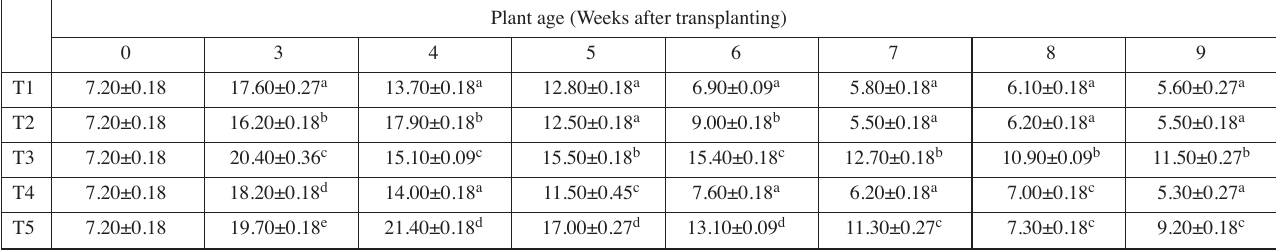
Plant age (Weeks after